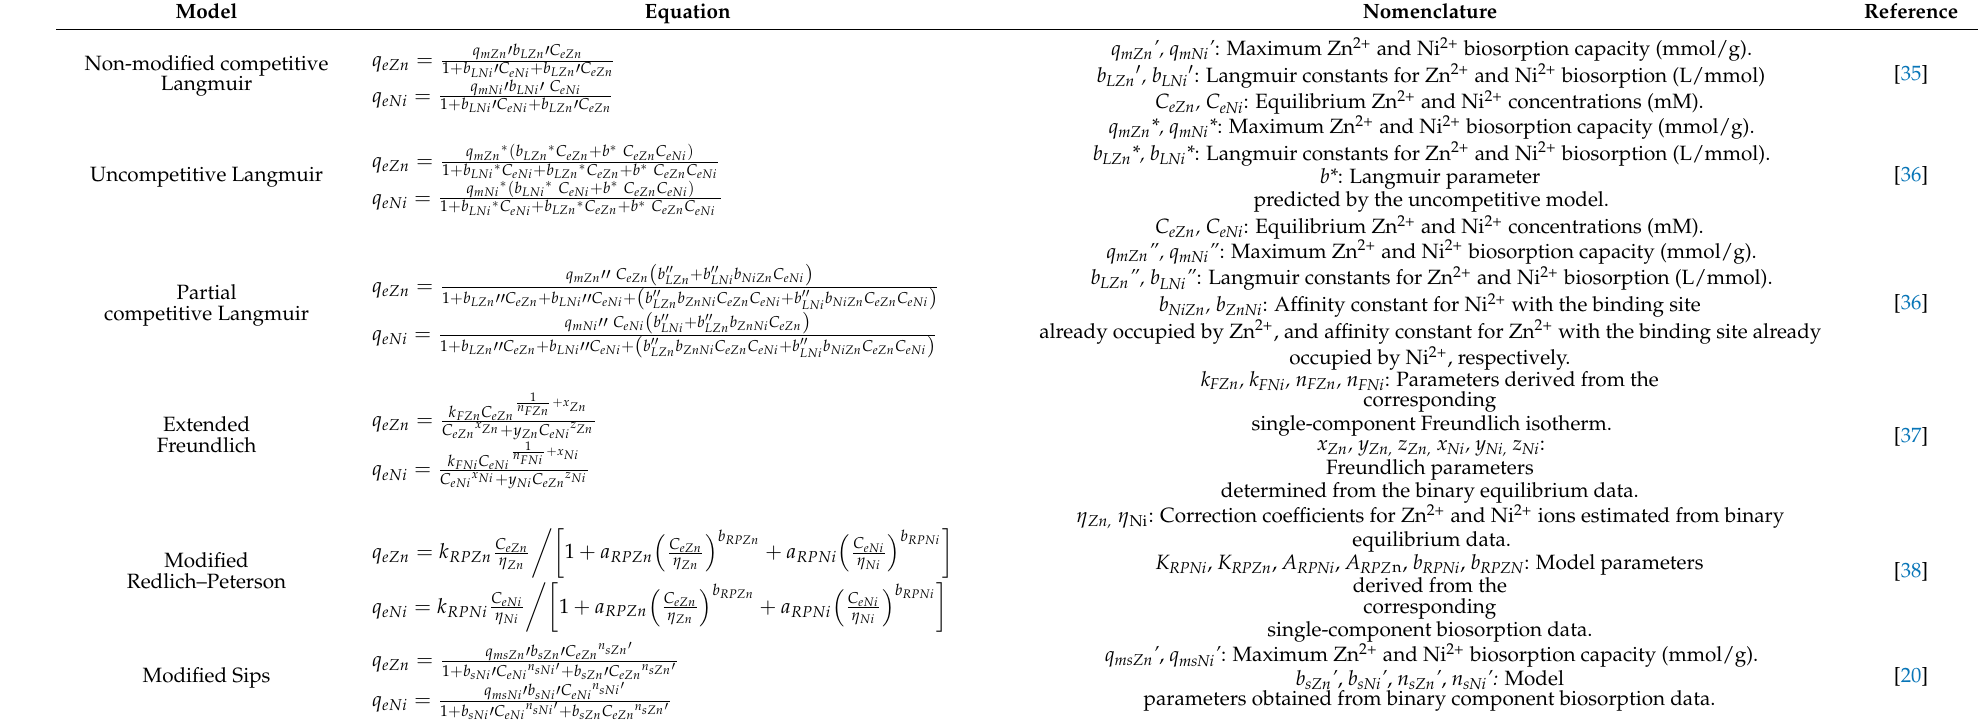
Table 2. Isotherm models used in this work for the binary biosorption of Zn 2+ and Ni 2+ by